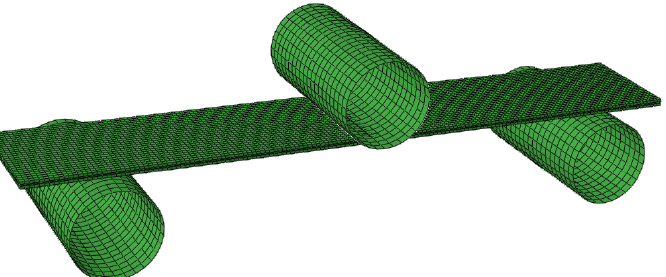
Figure 4. Finite element model of three-point bending test